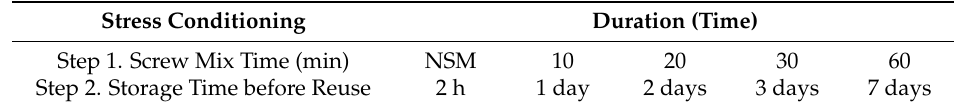
Table 4. Screw-mixing and storage time conditions.